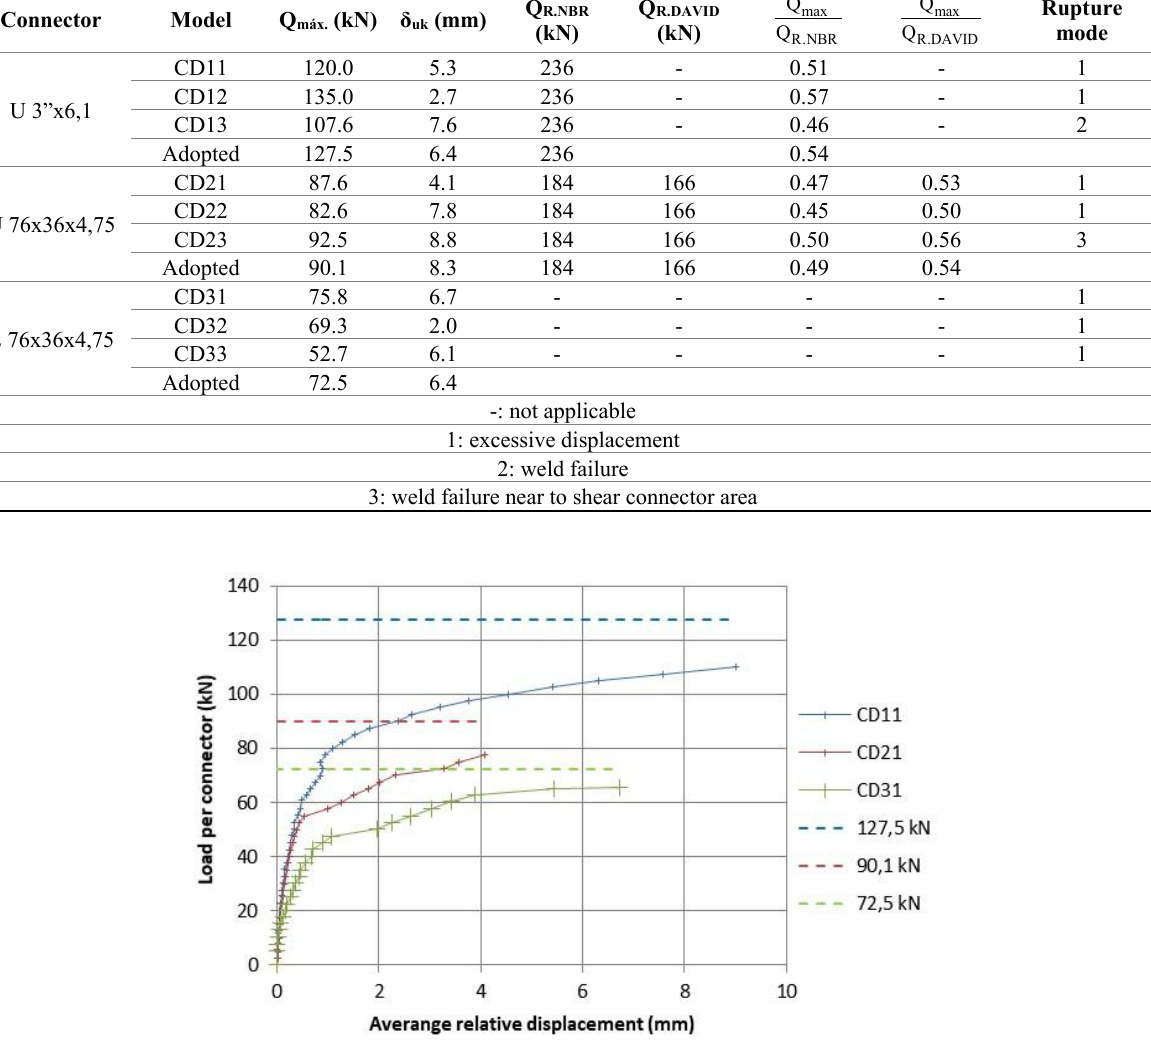
Table 5. Maximum force and relative displacement for the different connectors Connector